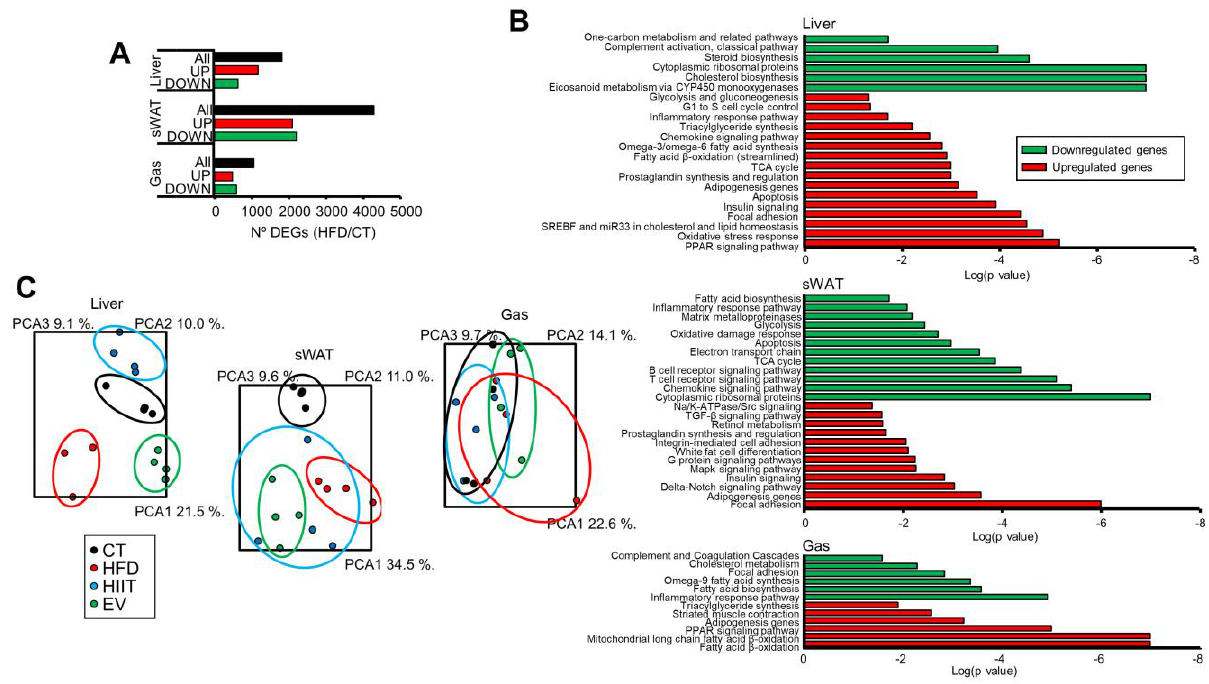
Figure 5. HIIT and EV-miRNAs affect the hepatic, sWAT, and muscle expression profiles of obese mice: ( A ) Number of total (black), upregulated (red), and downregulated (green) genes in the liver, sWAT, and gastrocnemius muscle that were significantly altered in HFD mice at least 1.5-fold in either direction; p < 0.05. ( B ) Enrichment analysis showing the log( p -value) of pathways associated with upregulated (red) or downregulated genes (green) in the same tissues of HFD mice. ( C ) Principal component analysis in these tissues showing that hepatic gene expression is strongly influenced by diet and treatment. N = 4/group ( A – C ).